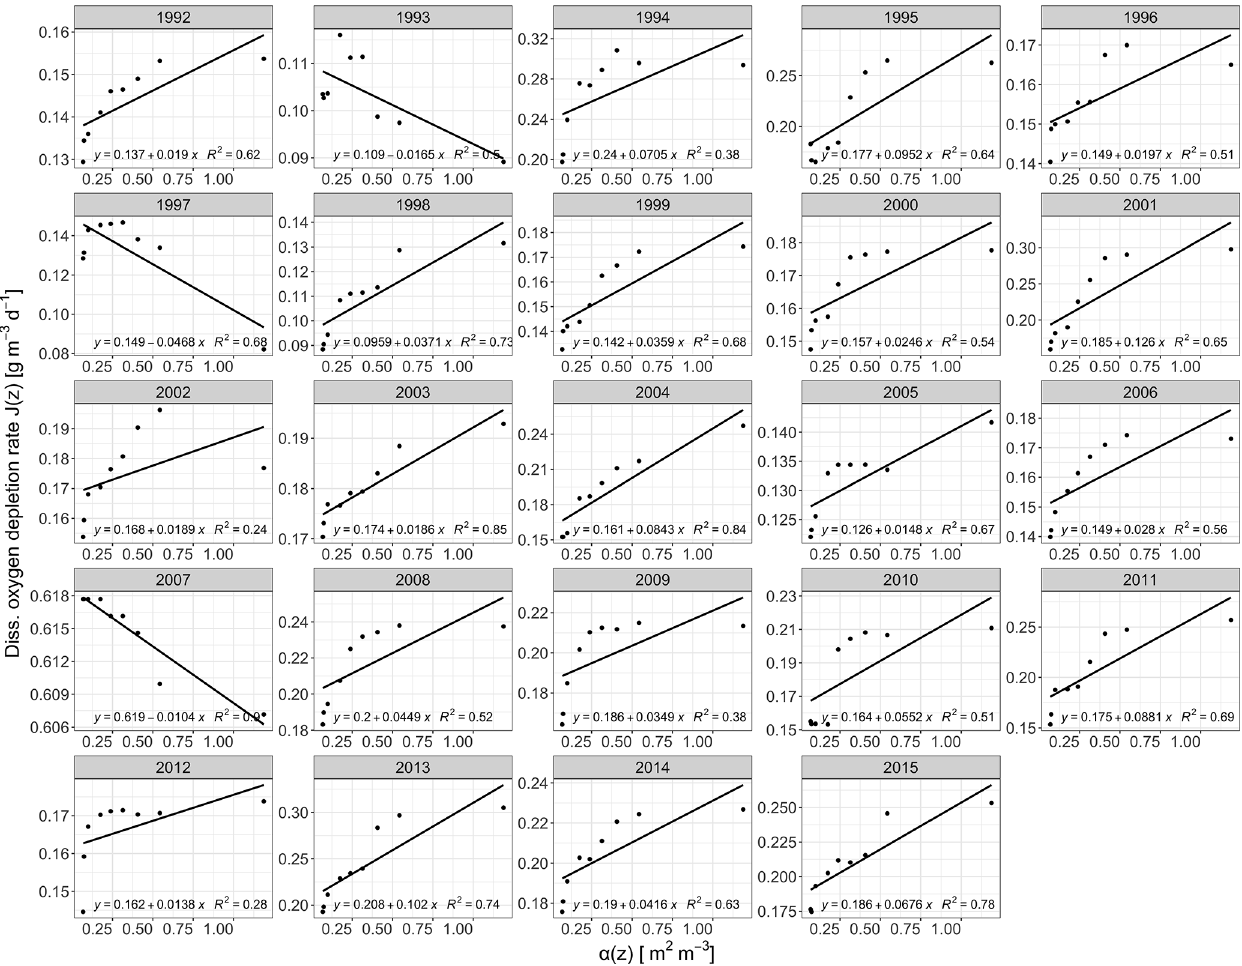
Figure 3. Regression plots of the morphometric function α(z) against oxygen depletion rates for the years 1992 to 2018, which were calculated from temporally linearly interpolated observed data. The respective equations represent weighted linear